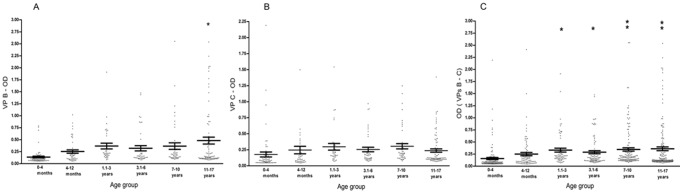
Serologic profile of serum antibody reactivity to SV40 mimotopes, VP1 B (Panel A), VP2/3 C (Panel B) and VPs both peptides B–C (Panel C).Data are presented as values of VPs B and C, OD readings at λ 405 nm, of serum samples diluted at 1∶20 detected in indirect ELISA testing. In scatter dot plotting, each plot represents the dispersion of OD values to a mean level, indicated by the line inside the scatter with standard error of the mean (SEM) for each age group of subjects analyzed. The OD readings of serum samples stratified by age of children were: 0.1–4 months, 4.1–12 months, 1.1–3 ys, 3.1–6 ys, 7–10 ys and 11–17 ys. Data were analyzed with one way Anova analysis, and Newman-Keuls Multiple Comparison Test (OD mean, 95% CI). Panel A. High levels of antibodies against SV40 VP1 B, mean OD values, were observed in children aged 11–17 ys (0.48 OD, 95% CI = 0.34–0.62) vs. children aged 0.1–4 months (0.13 OD, 95% CI = 0.10–0.17) (P<0.001) and vs. children aged 4.1–12 months (0.25 OD, CI = 0.18–0.32), with P<0.05. Panel B. The different levels of antibodies against SV40VP1 peptide C, mean OD values, were not statistically significant among children. Panel C. High levels of antibodies against SV40VPs, both peptides B and C, mean OD values, were observed in children aged 1.1–3 ys (0.33 OD, CI = 0.25–0.41), and 3.1–6 ys (0.28 OD, CI = 0.22–0.35) vs. children aged 0.1–4 months (0.16 OD, CI = 0.11–0.20), with *P<0.05. Highest level of mean OD values were observed in children aged 7–10 ys (0.35 OD, CI = 0.28–0.41) and 11–17 ys (0.36 OD, CI = 0.28–0.44) vs. children aged 0.1–4 months., with **P<0.001.